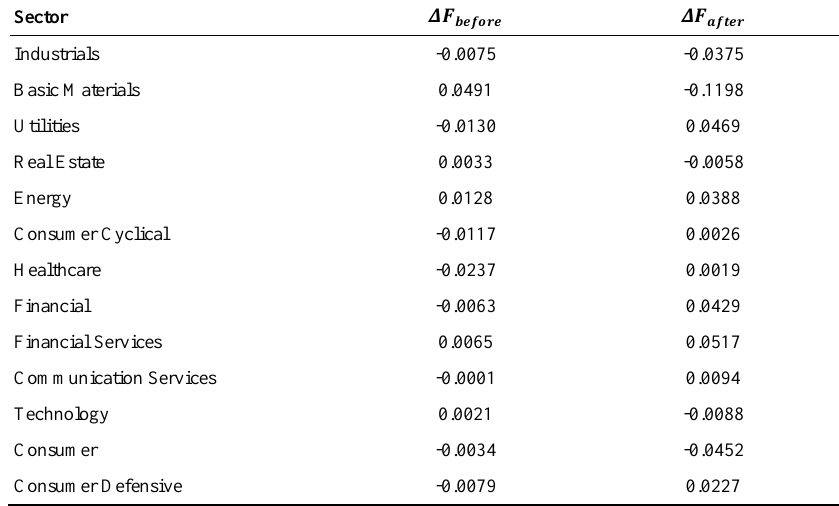
Table 12. The net information outflow for the sectors in S&P TSX market, before and after COVID-19 outbreak